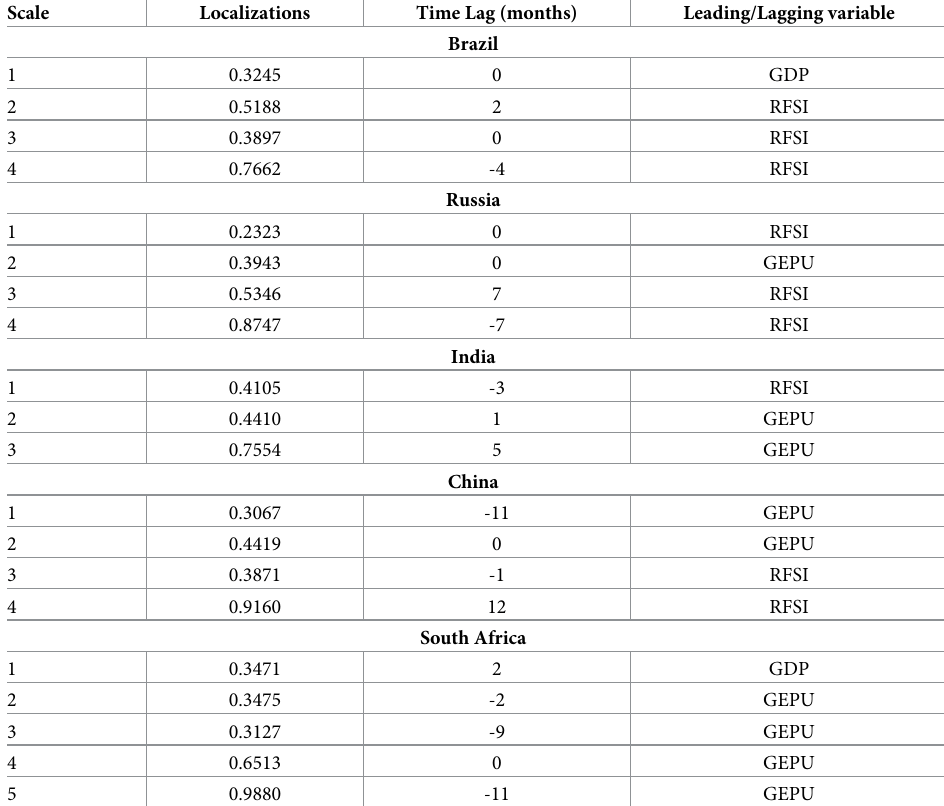
Table 4. Wavelet multiple cross correlations